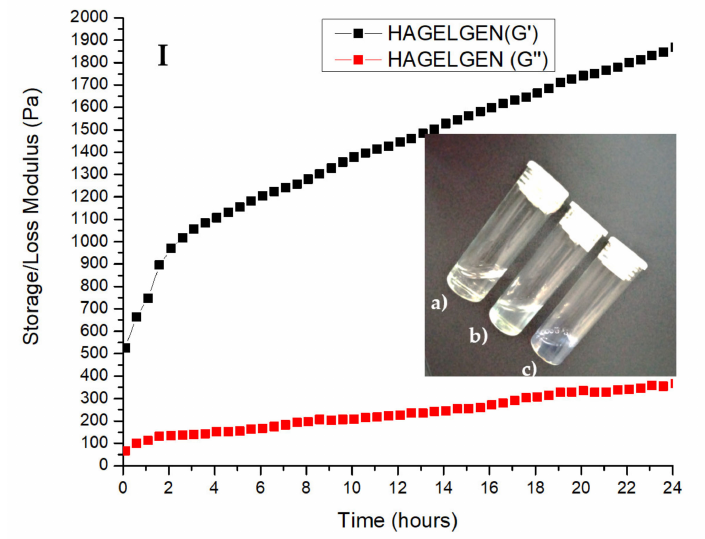
Figure 4. Storage (G (cid:48) ) and loss (G (cid:48)(cid:48) ) modulus of ( A ) chitosan, ( B ) gelatin, ( C ) GELGEN, ( D ) CHTGEN, ( E ) CGG, ( F ) CHTGEL, ( G ) HA, ( H ) HAGEL and ( I ) HAGELGEN. Photographs on each graph show the tilt-bottle test results of each hydrogel at different times of crosslinking: (a) 0 h, (b) 12 h and (c) 24